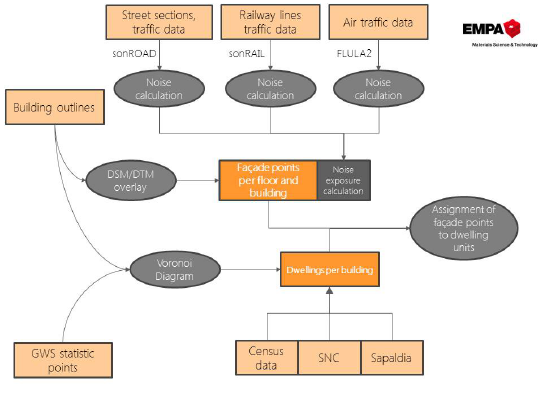
Fig. 1. Flow chart depicting the data processing, from the input data to the exposure analysis. Further information about sonROAD is available in [26], for sonRAIL in [27] and FLULA2 in [28].